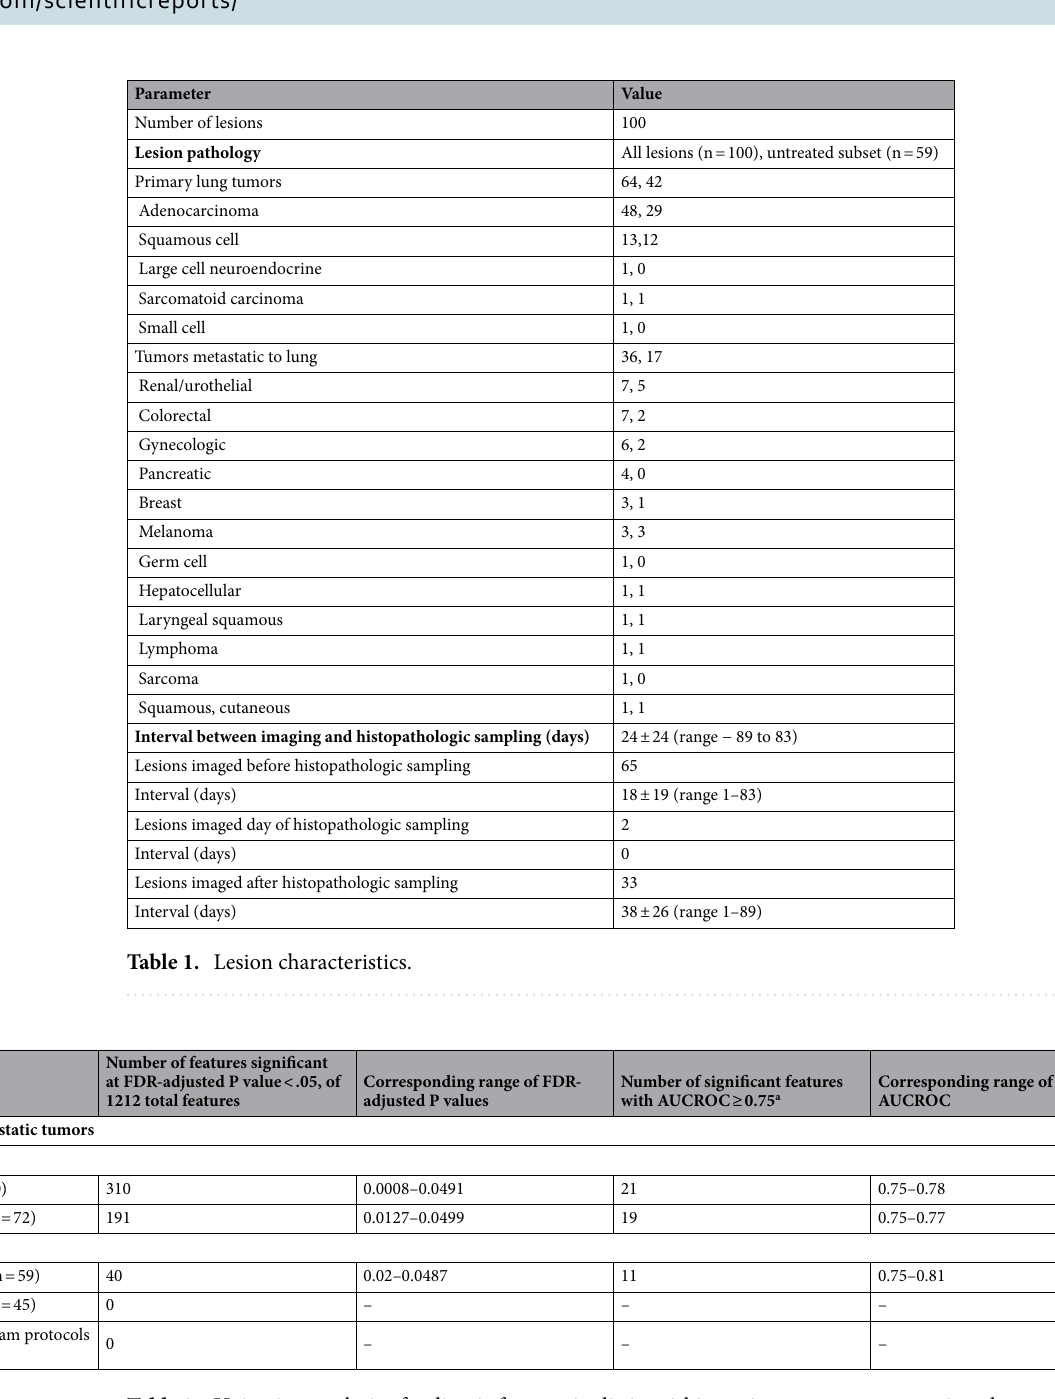
Table 2. Univariate analysis of radiomic features in distinguishing primary versus metastatic pulmonary tumors. a Specific features listed in Table